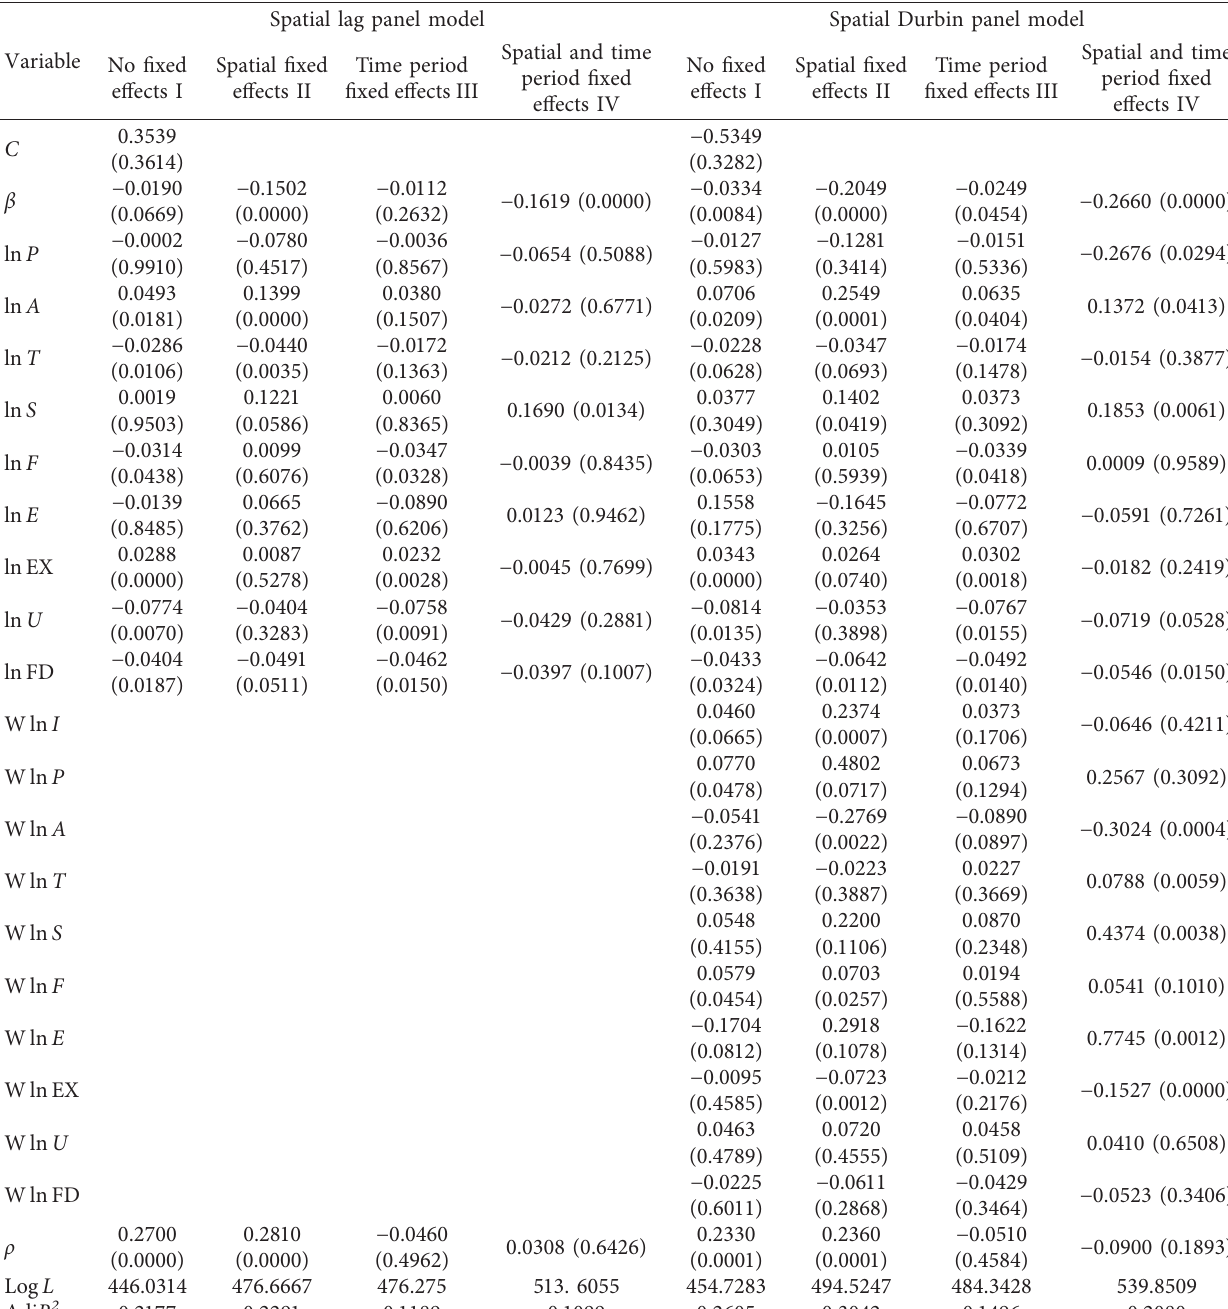
Table 4: Spatial estimation results of provincial carbon